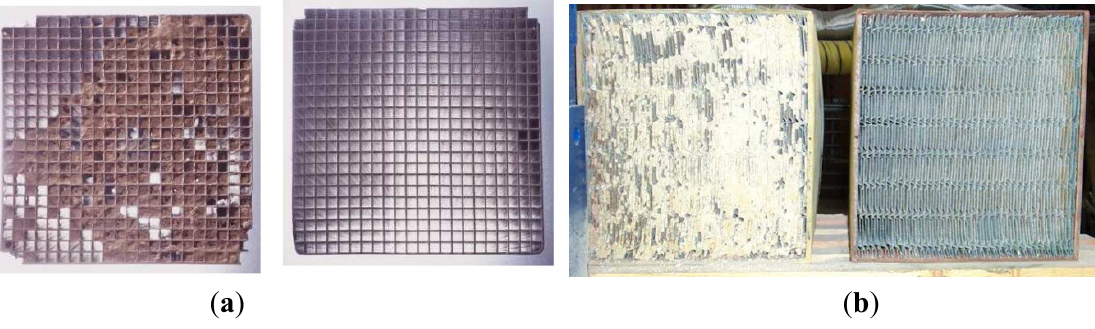
Figure 44. ( a ) Monolith and ( b ) plate SCR catalysts before and after SCR-Tech regenerative treatment. Reproduced from [334]. Courtesy CoaLogix, Inc.